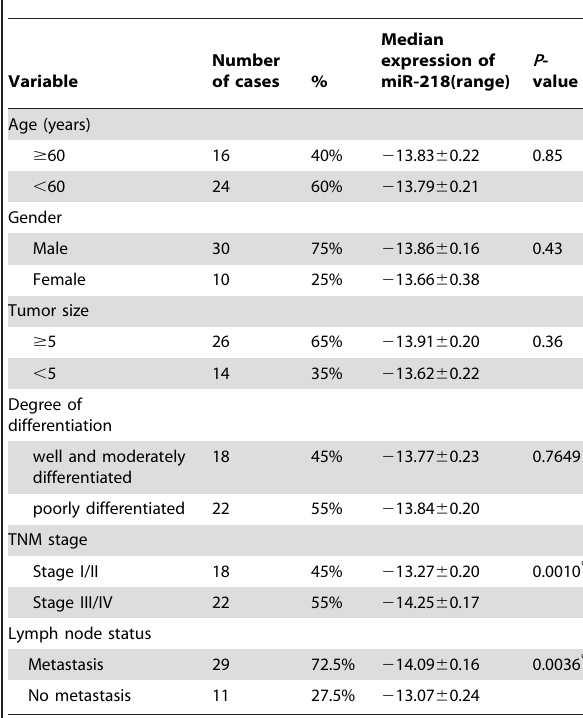
Table 1. The relationship between clinicopathological parameters and miR-218 expression in primary gastric adenocarcinoma.